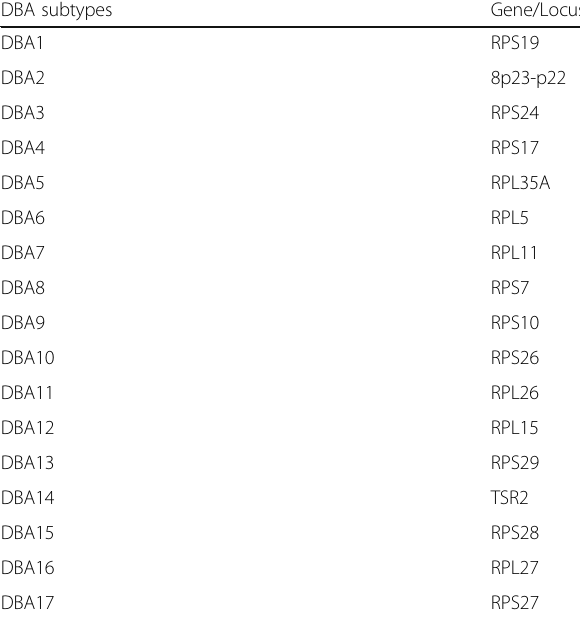
Table 1 Subtypes of DBA and related